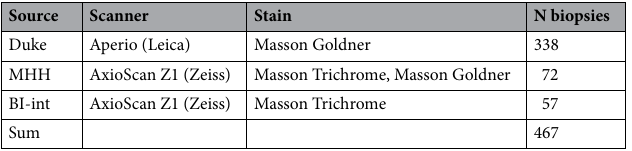
Table 2. Overview on training data: sources, scanners, stains, and number of